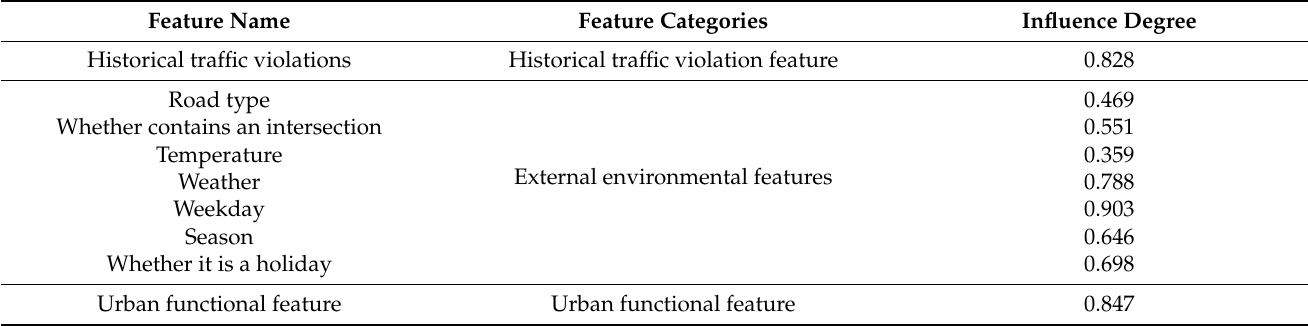
Table 4. The degree of input features.